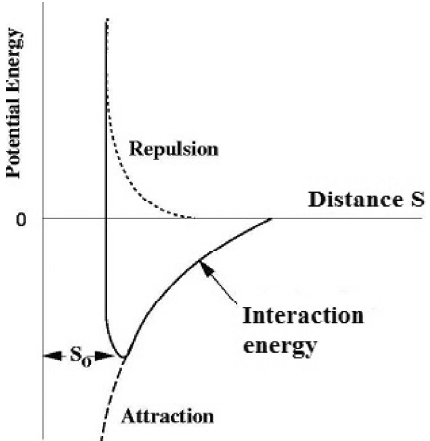
Fig. 2. Potential energy of van der Waals interac- tion between two particles: So – the distance of stable equilibrium between the repulsion and attrac- tion forces (replotted regarding to the data from